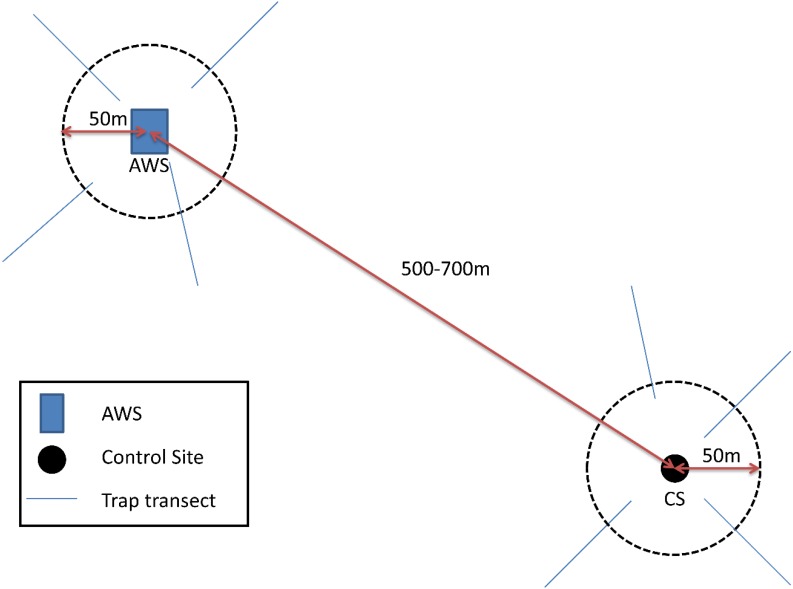
Configuration of randomly placed trapping transects around anthropogenic water sources (AWS) and control sites (CS) to sample small mammal communities during winter 2011 and spring 2012 on Barry M. Goldwater Range in Maricopa County, Arizona, USA.Control sites originated from random points generated in GIS and located 500–700 m from AWS. Transect starting locations were randomized, as were the orientation or bearing of transects, and placed within 50 m of AWS or CS.